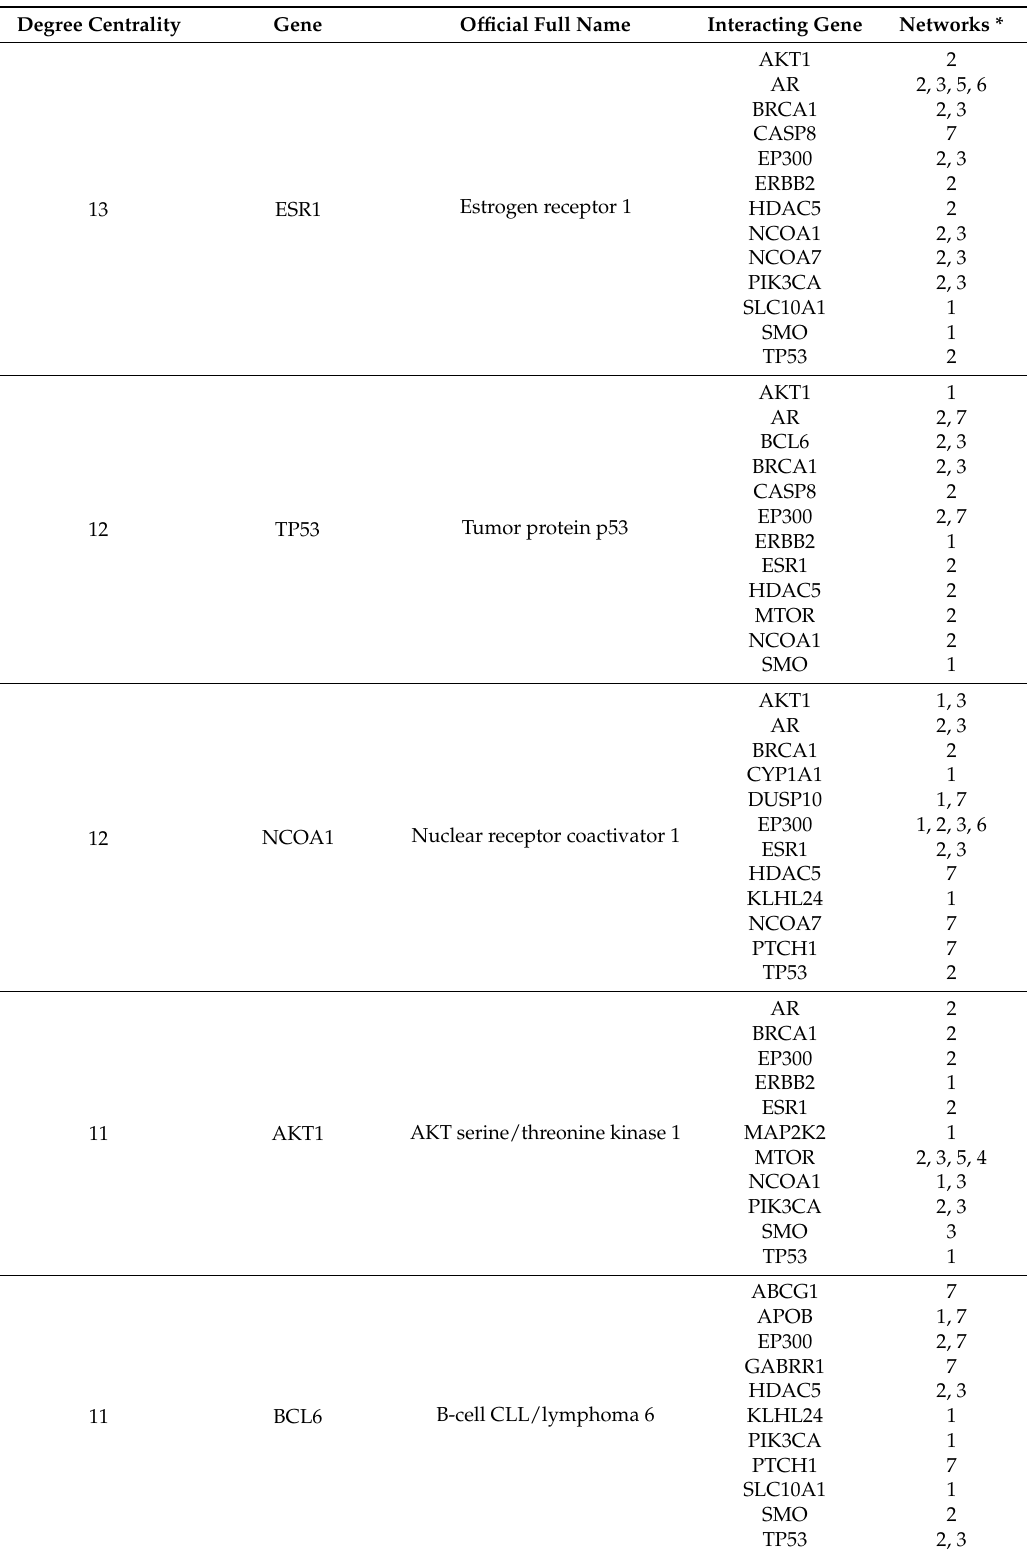
Table 2. Top five genes with the highest centrality and their interacting genes and networks based on the GeneMANIA network